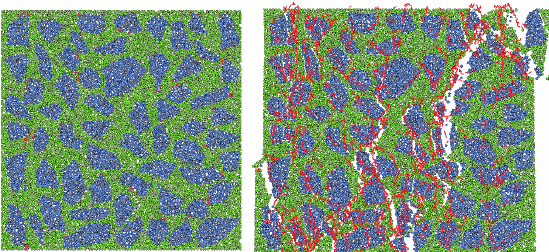
Figure 16: The initial and final figure of UCT in PFC 2D